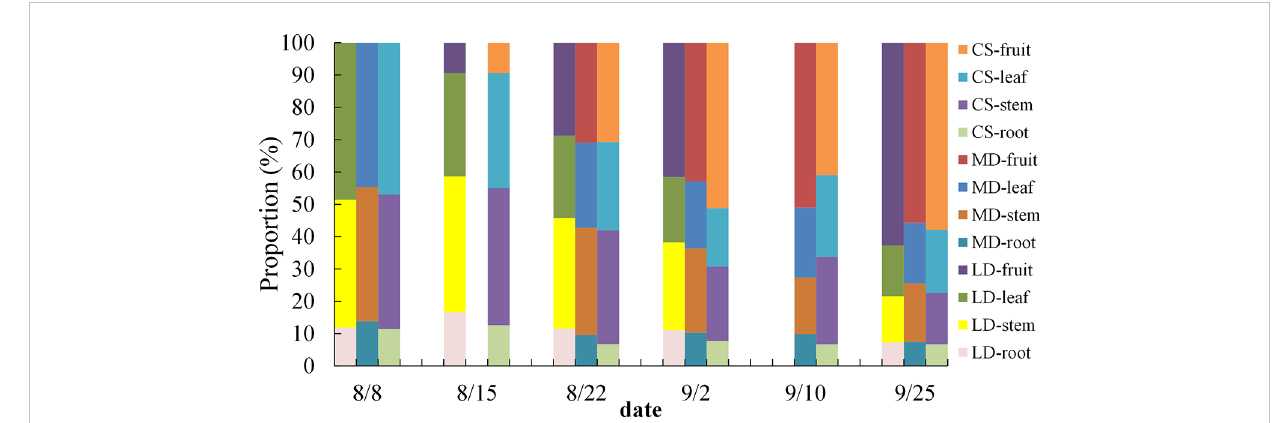
FIGURE 5 Dynamic change analysis of the biomass proportion of summer maize under different drought